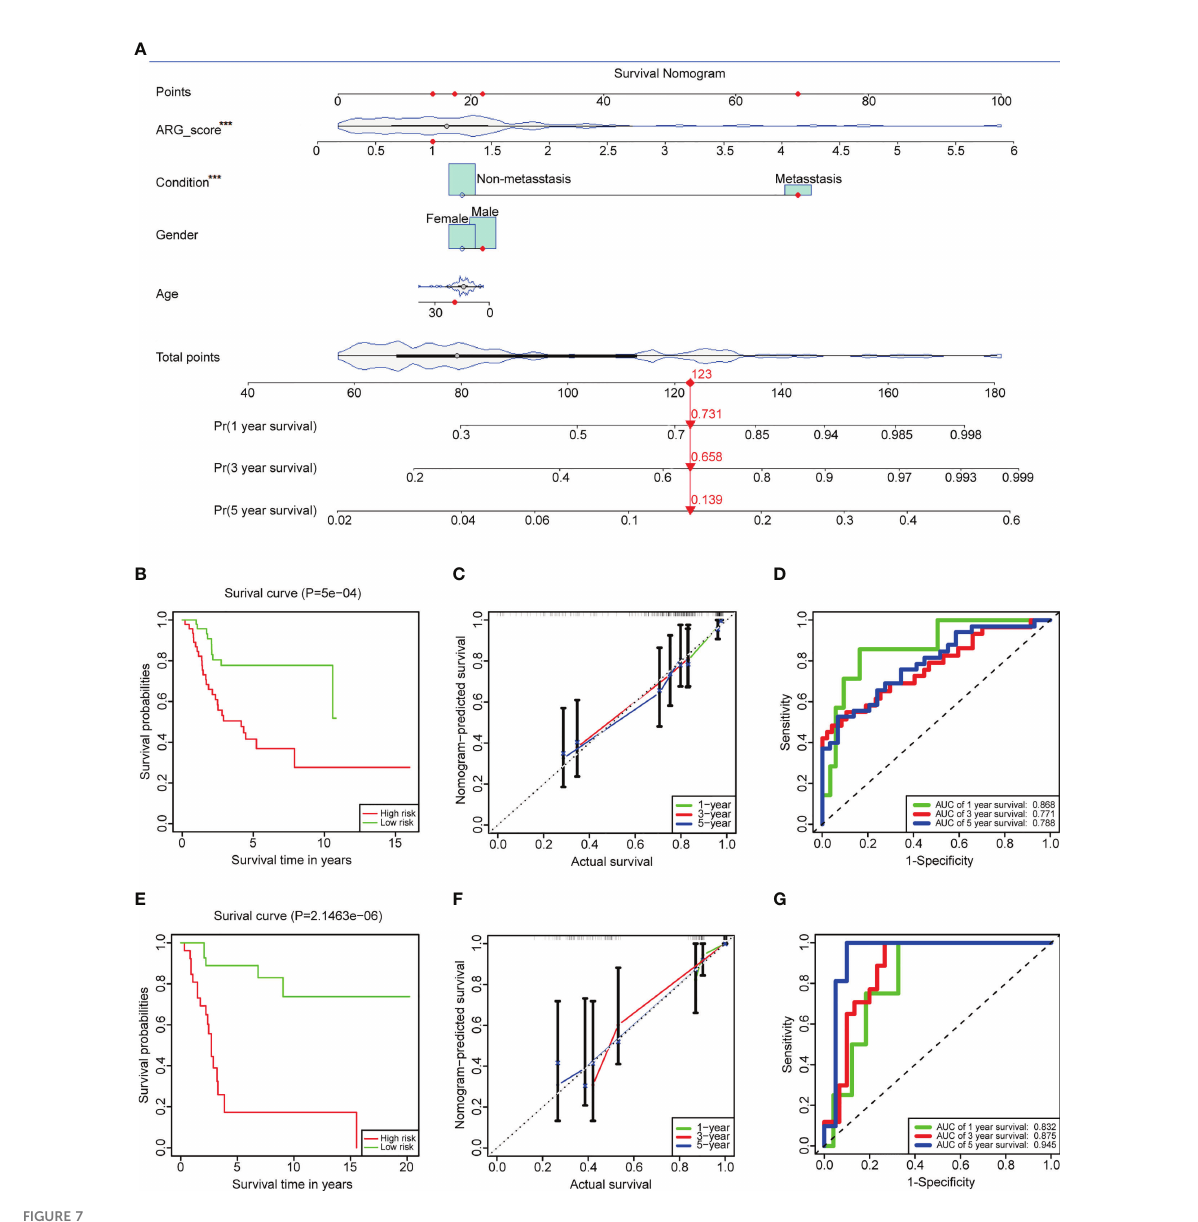
FIGURE 7 Construction and validation of the prediction model. (A) An interactive nomogram built by ARG_score and clinical features. (B) K-M plots comparing the overall survival between the low- and high-risk groups in the TARGET dataset (log-rank p -value = 5e − 4). (C) Calibration curves to analyze the accuracy of the 1-, 3-, and 5-year survival according to the prediction model of the TARGET dataset. (D) Time-dependent ROC curves to predict the discrimination of the 1-, 3-, and 5-year survival according to the prediction model of the TARGET dataset. (E – G) K-M plots, calibration curves, and time-dependent ROC curves in GSE21257, which served as a validation dataset. The symbol *** represents that ARG_score and condition were identi fi ed as independent factors in the prediction model, which had a p value <